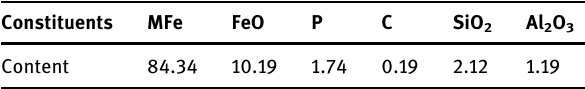
Table 1: Chemical compositions of reduced iron ( wt%